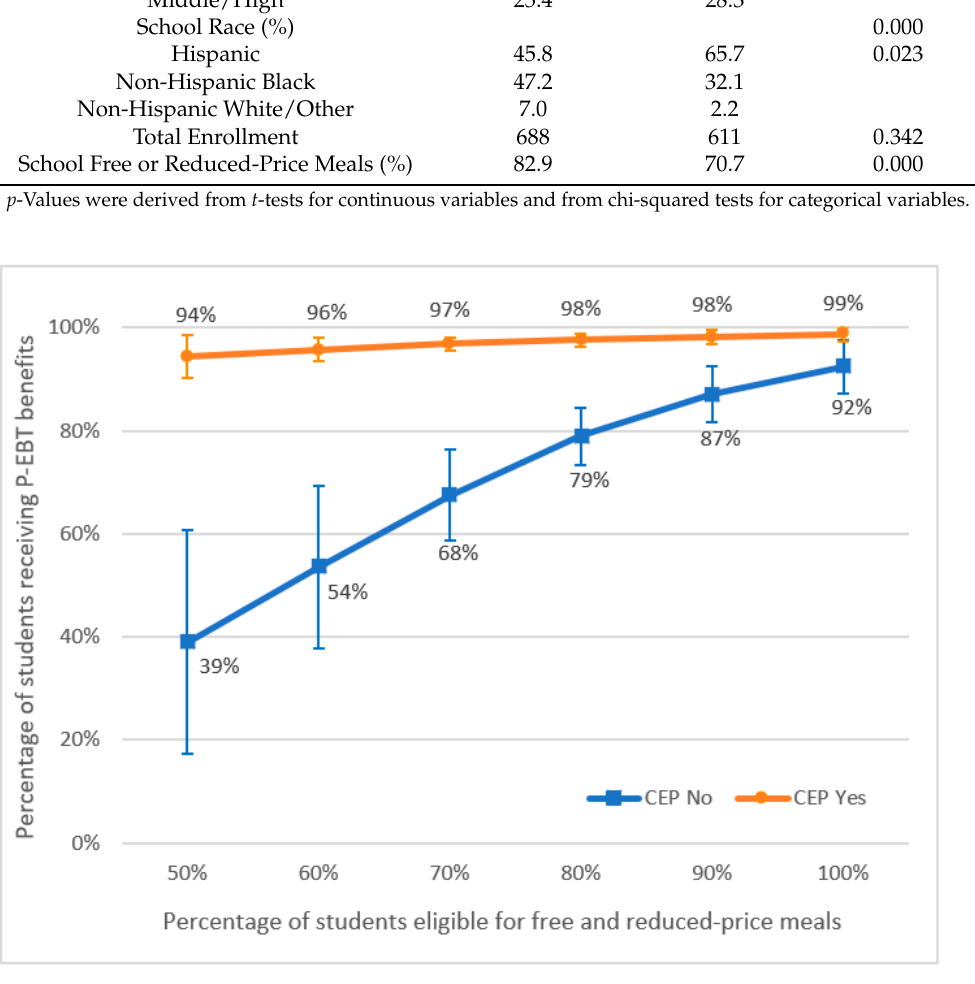
Table 1. Descriptive characteristics of the schools included in the analysis by CEP status ( n = 105).